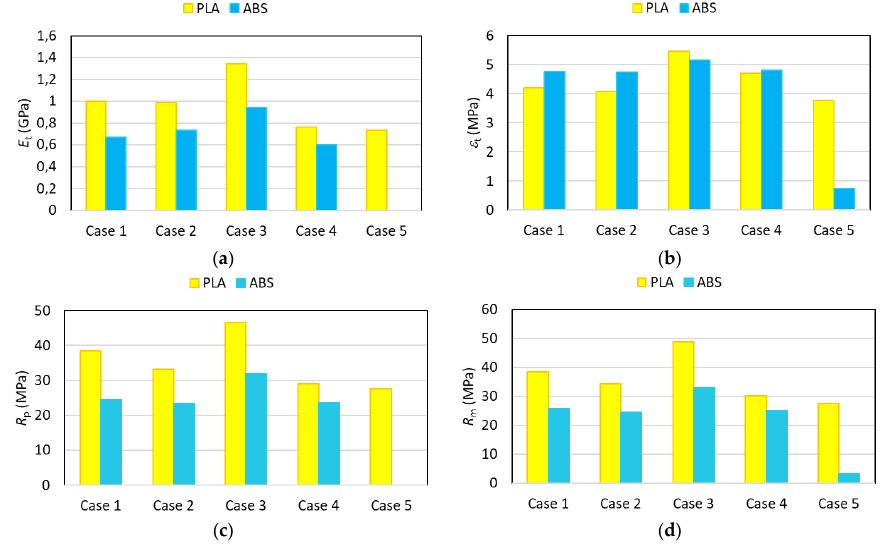
Figure 13. The comparison of mechanical properties for PLA and ABS. ( a ) Modulus of elasticity; ( b ) Nominal strain at break; ( c ) Yield stress; ( d ) Tensile strength.